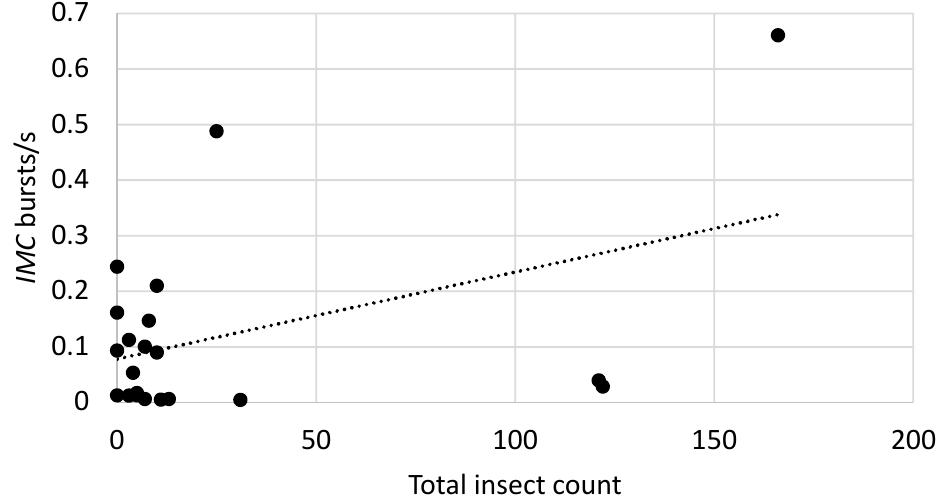
Figure 2. Relationship between insect sound burst rates and total counts of P. truncatus and S. zeamais for the IMC system in recordings from 21 bags at Kiganjo, Nairobi, Nakuru, and Sagana warehouses. Filled circles indicate burst rates from individual bags with specified total counts of the two species. Dotted line indicates the linear regression of insect sound bursts/s on the total counts.